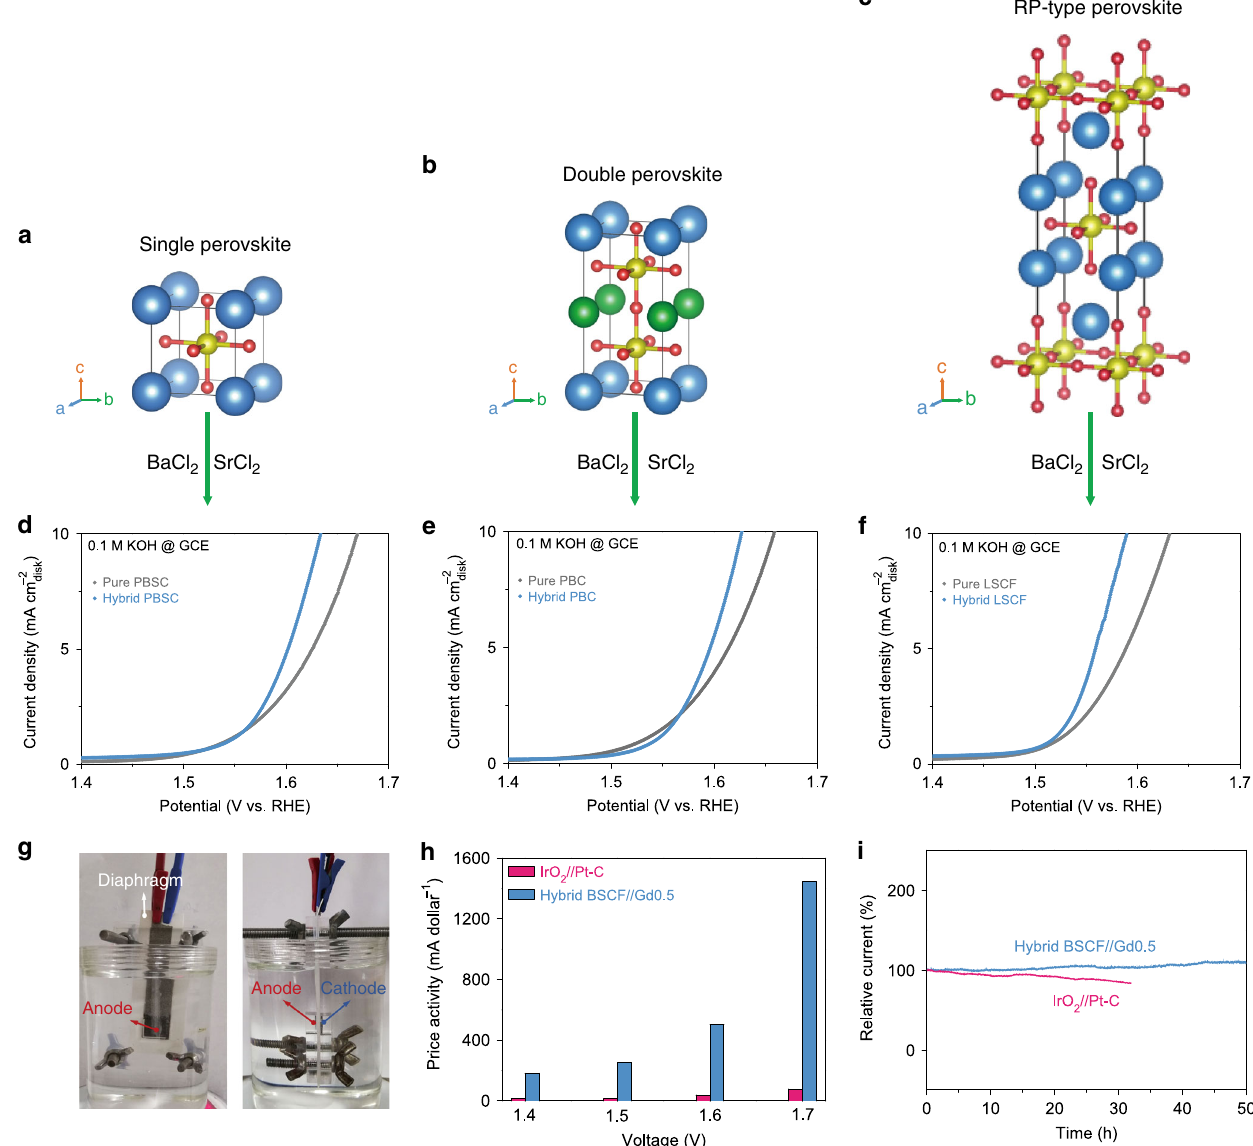
Fig. 5 Reliability of strategy and water splitting application. Crystal structures of a single, b double, and c RP-type perovskites. d – f OER performance of pure and hybrid perovskites measured on GCE in 0.1 M KOH at 25 °C. g A back-to-back water electrolyzer. h The price activity and i stability of hybrid BSCF//Gd0.5 and IrO 2 //Pt-C electrodes for water splitting tested on nickel foam in 1 M KOH at 25 °C. The catalyst loading for water splitting electrodes was 3 mg cm − 2